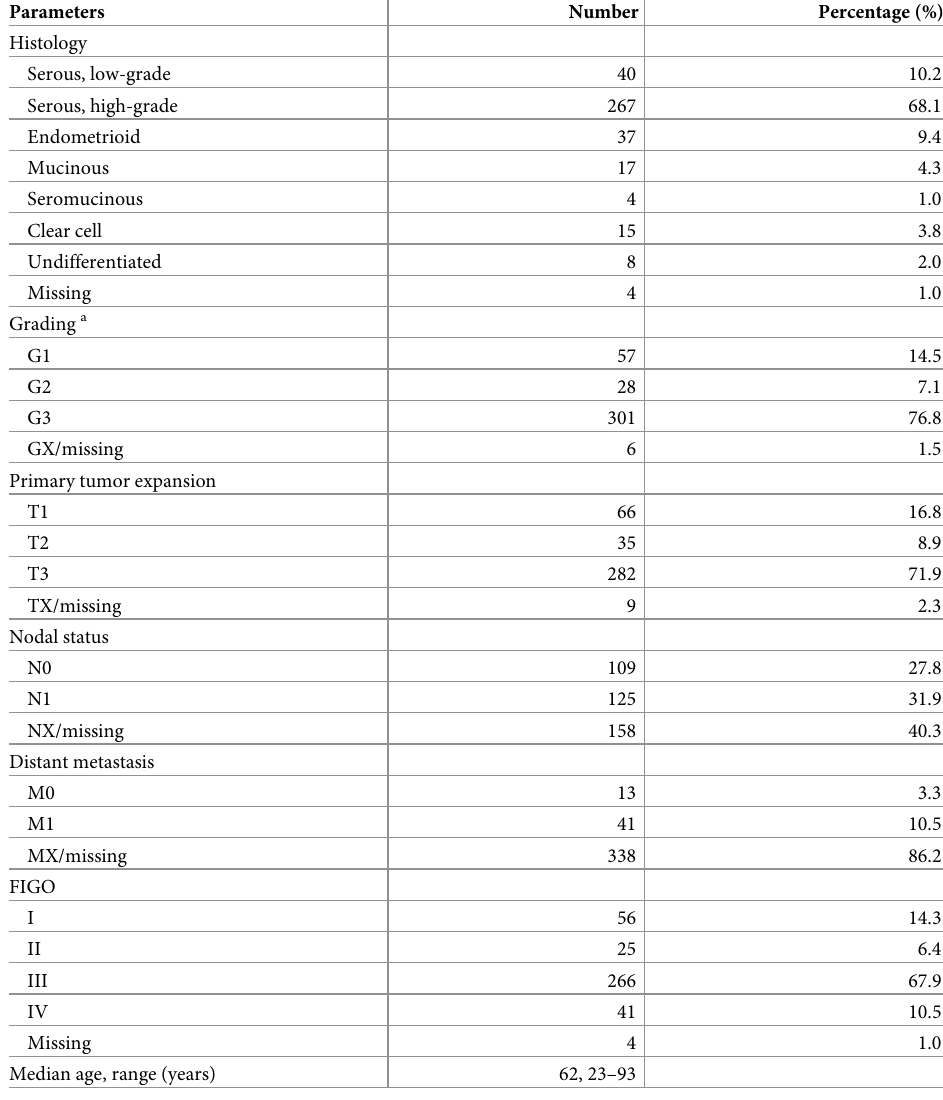
Table 1. Patient characteristics of the analyzed OC tissue samples.